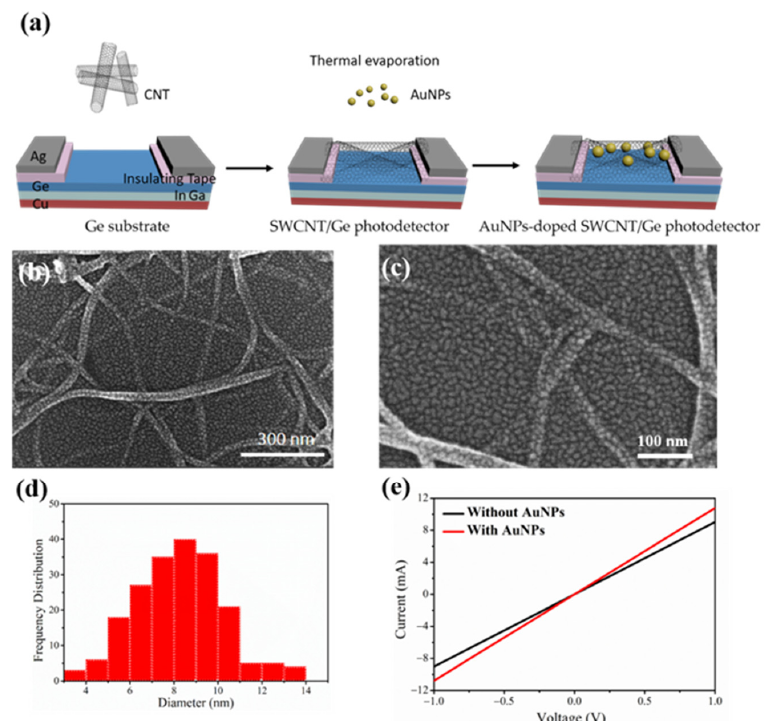
Figure 1. ( a ): Schematic illustration of the AuNPs-doped SWCNT/Ge photodetector; ( b ) and ( c ): SEM image of the AuNPs-modified SWNT/Ge interface; ( d ): Statistical particle size distribution of the AuNPs; and ( e ): I-V curves of the SWNT films with and without gold nanoparticles .